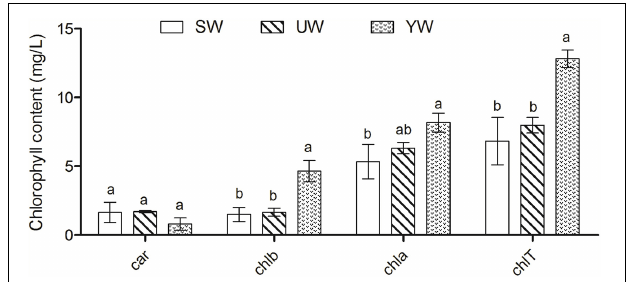
FIGURE 1 | Effects of geographical location on leaf chlorophyll content in G. uralensis . Bar charts (mean with standard error) with different lower-case letters represented a significant difference ( p < 0.05) was assessed by one-way analysis of variance followed by Bonferroni’s statistic test for multiple comparisons. The same letter indicates no significant difference ( p > 0.05). Car, carotenoid contents; chlb, chlorophyll b; chla, chlorophyll a; chlT, total